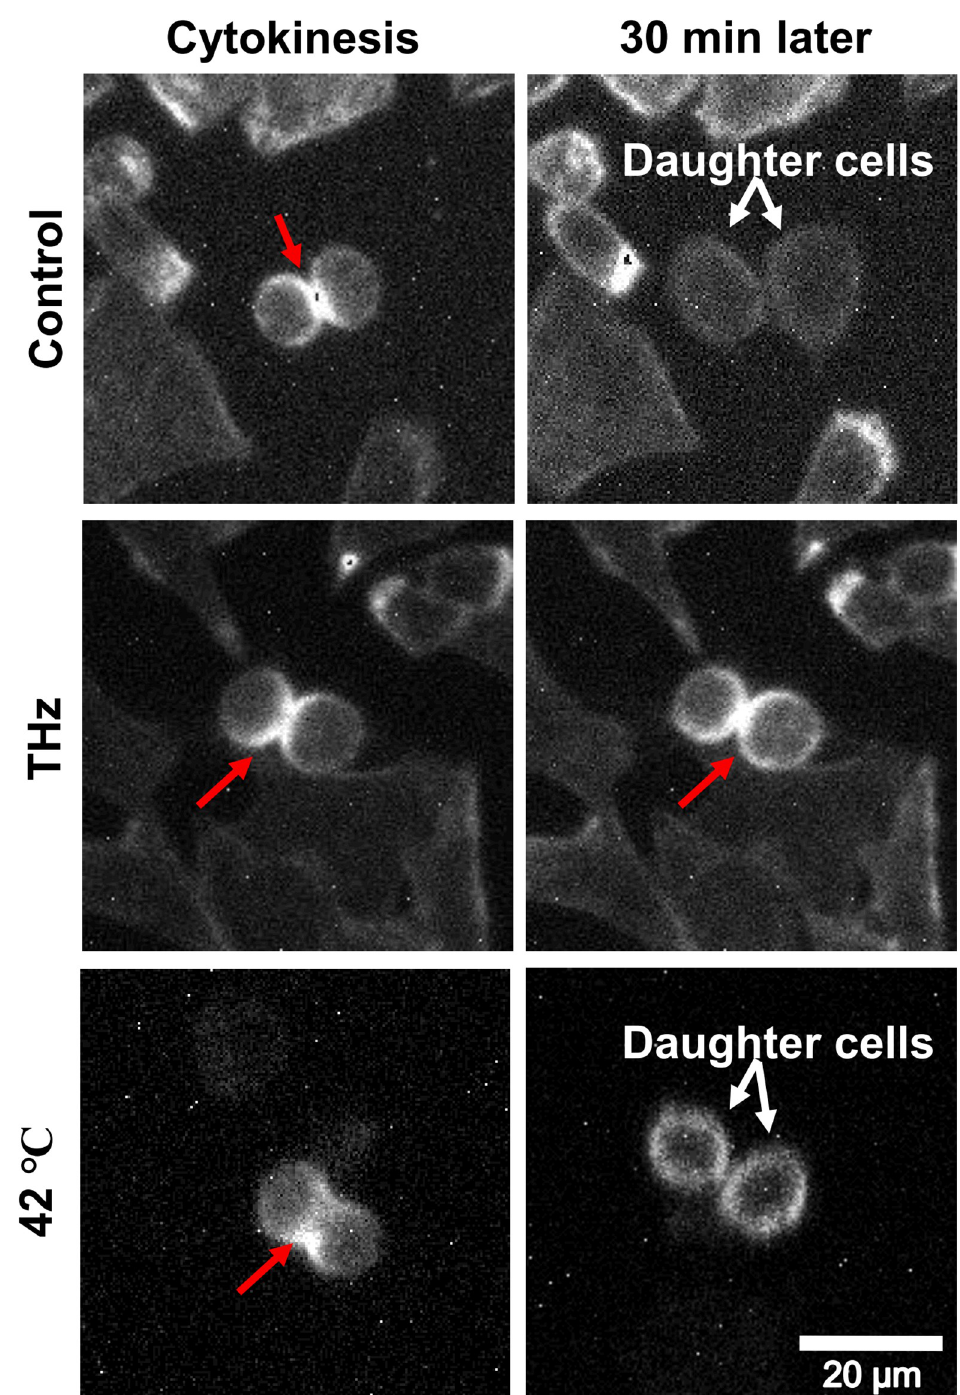
Fig 3. Persistence of the contractile ring during THz irradiation. Live-cell imaging of cells with a contractile ring. The cellular actin filaments were stained with SiR-actin and observed 30 minutes after generation of the contractile ring. The culture medium was kept at 37 ˚C by the heating stage during the experiments with and without THz irradiation. To observe the thermal effects on cytokinesis progression, cells were cultured at 42 ˚C and observed (bottom panel). The red arrows show the contractile ring and the white arrows show the daughter cells. The white bar shows a scale of 20 μ m.